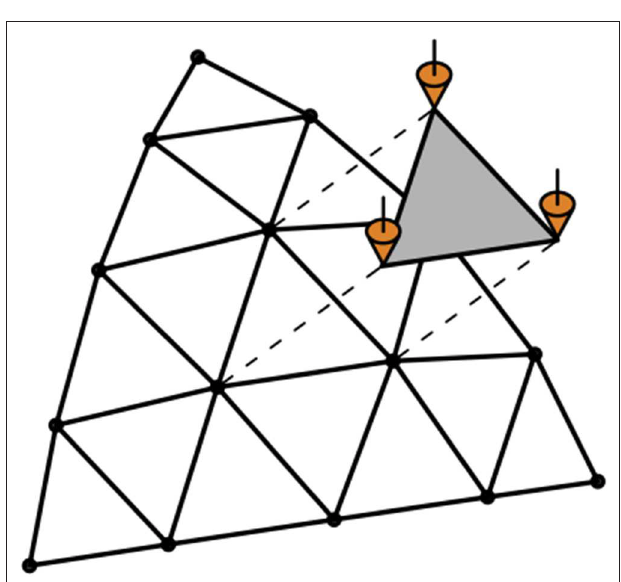
FIGURE 3 | A gravity load of 2 kNm − 2 is assigned to the nodes using the shape functions of triangular shell